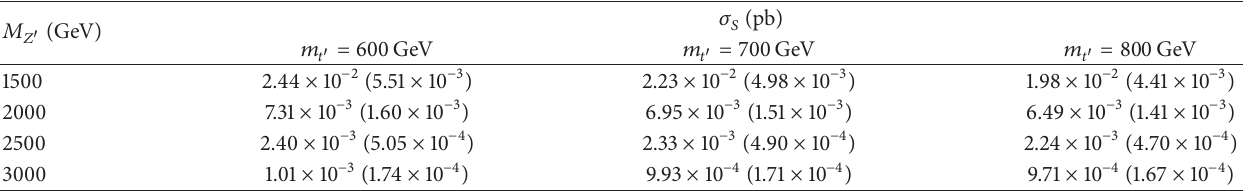
Table 3: The total cross section for the signal ( 𝜎 𝑆 ) depending on the 𝑍 󸀠 boson mass. These values are calculated for the process 𝑝𝑝 → (𝑊 + 𝑏𝑡 + 𝑊 − 𝑏𝑡) + 𝑋 at the LHC with √𝑠 = 13 TeV. The results are obtained for the 𝑍 󸀠 𝑥 = 0.01 .